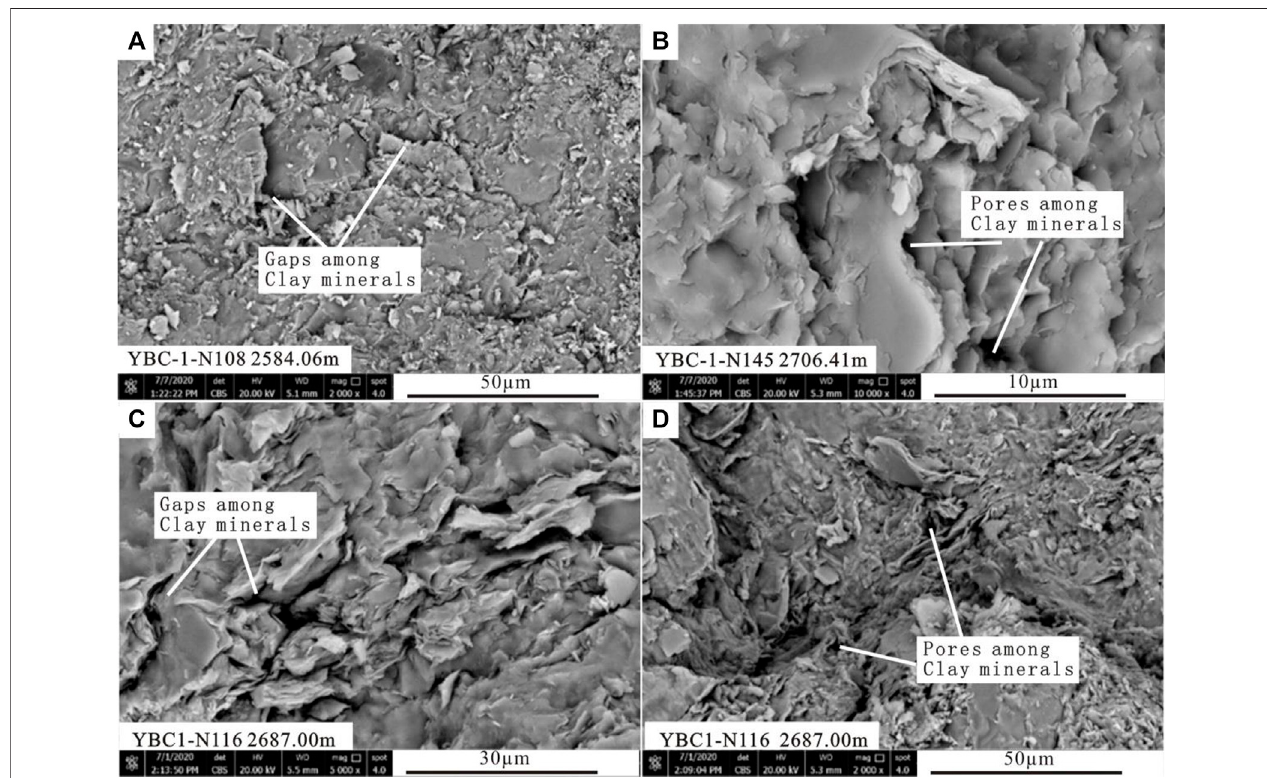
FIGURE 8 | SEM images of interparticle pores related to clay minerals in Shanxi Formation shale. (A,C) gaps among clay minerals; (B,D) pores among clay minerals.